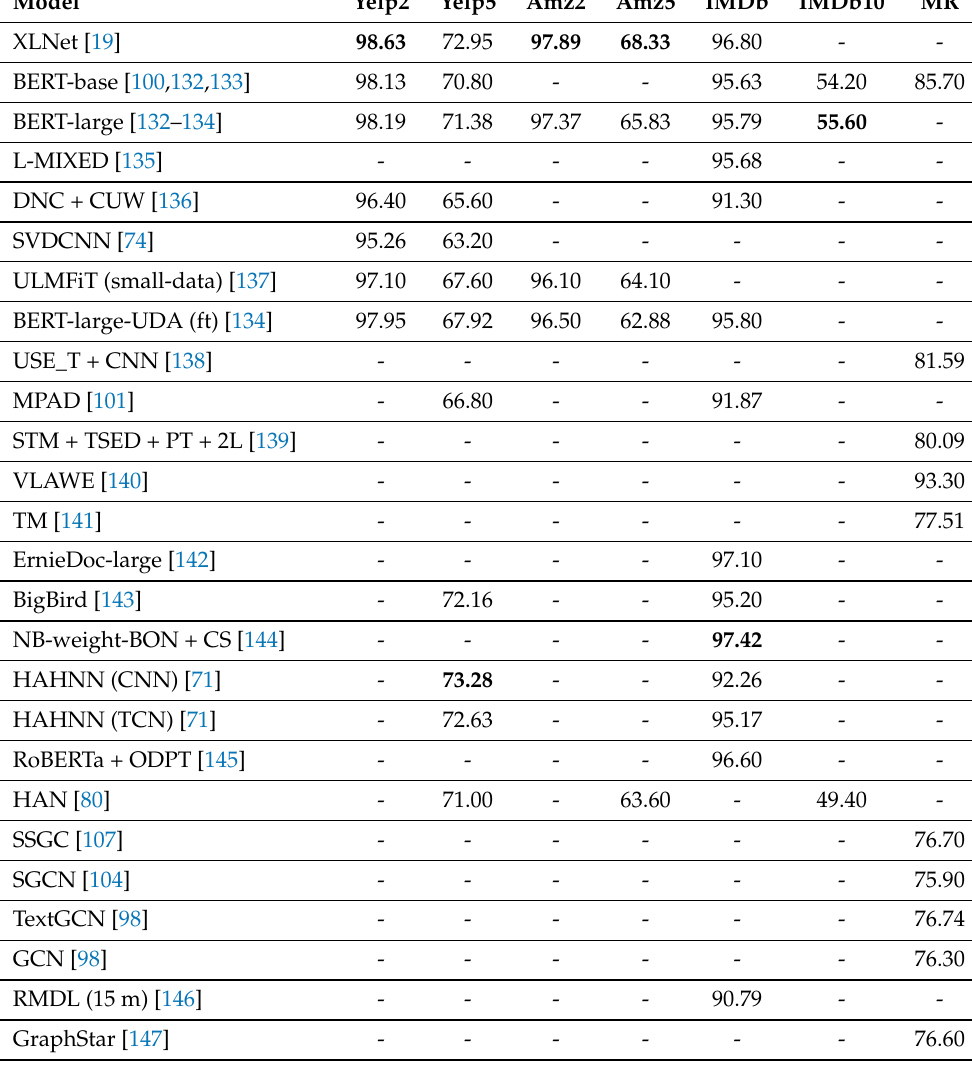
Table 4. Test accuracy score (%) on SA benchmark datasets (best results in bold).